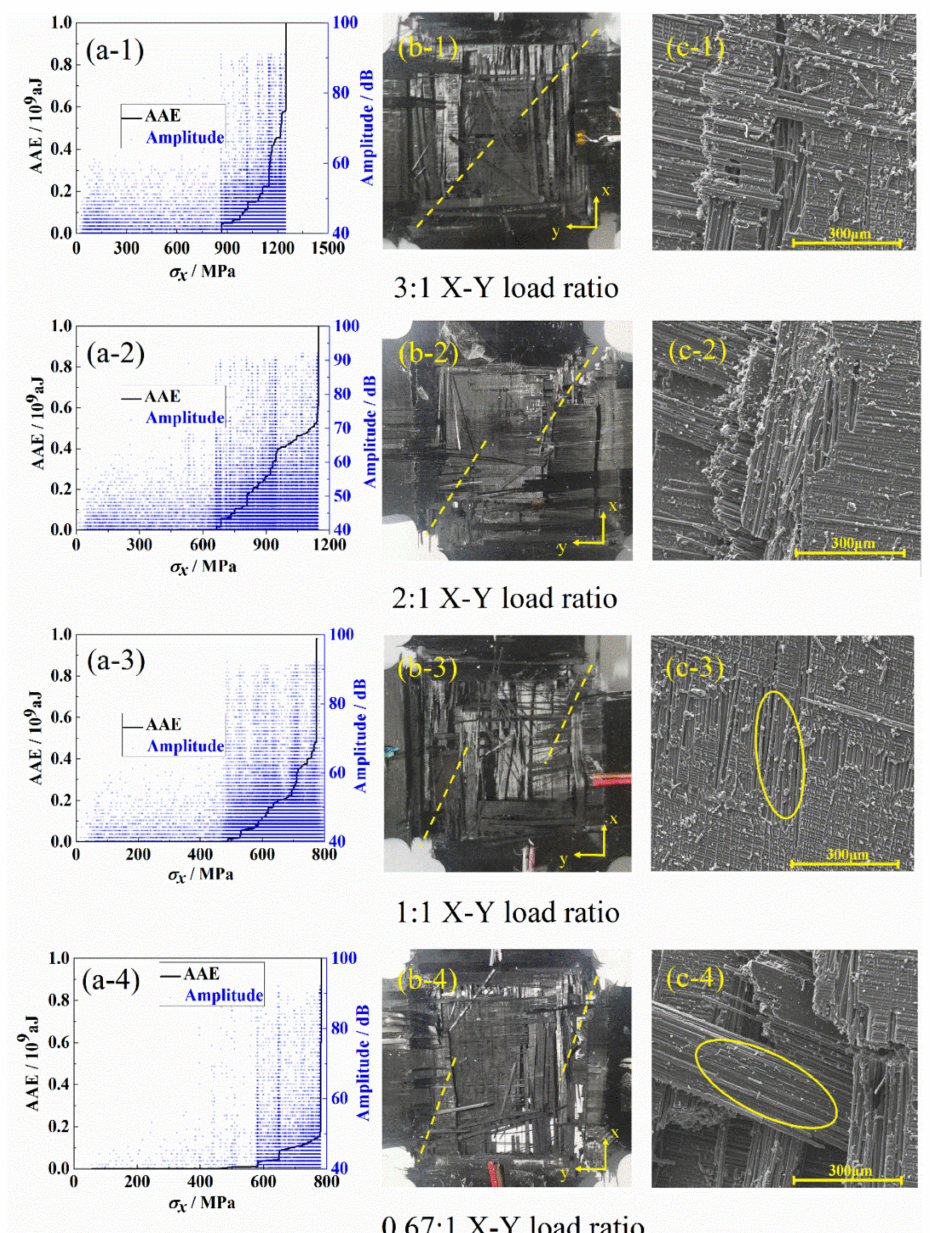
Figure 12. Failure mode and morphology analysis by ( a ) acoustic emission, ( b ) macroscopic damage morphology, and ( c ) SEM images of bare fiber